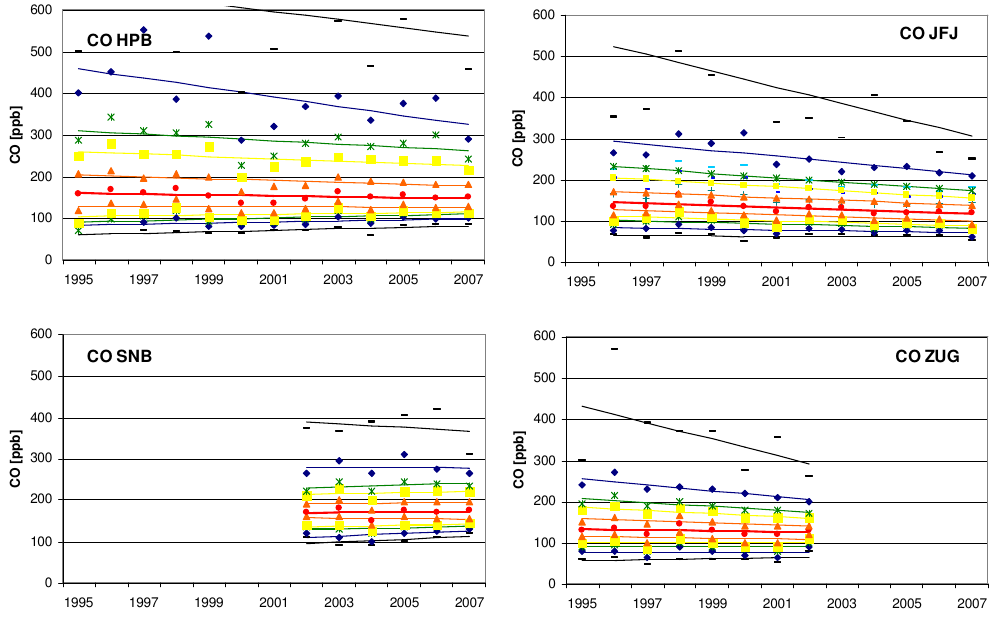
Fig. 9. CO time series of annual percentiles and respective linear trends at the “DACH” sites. since 1995; black: minimum and maximum, blue: 1- /99- ; green: 5- /95- , yellow: 10- /90- ; orange: 25- /75-percentiles, red: median.